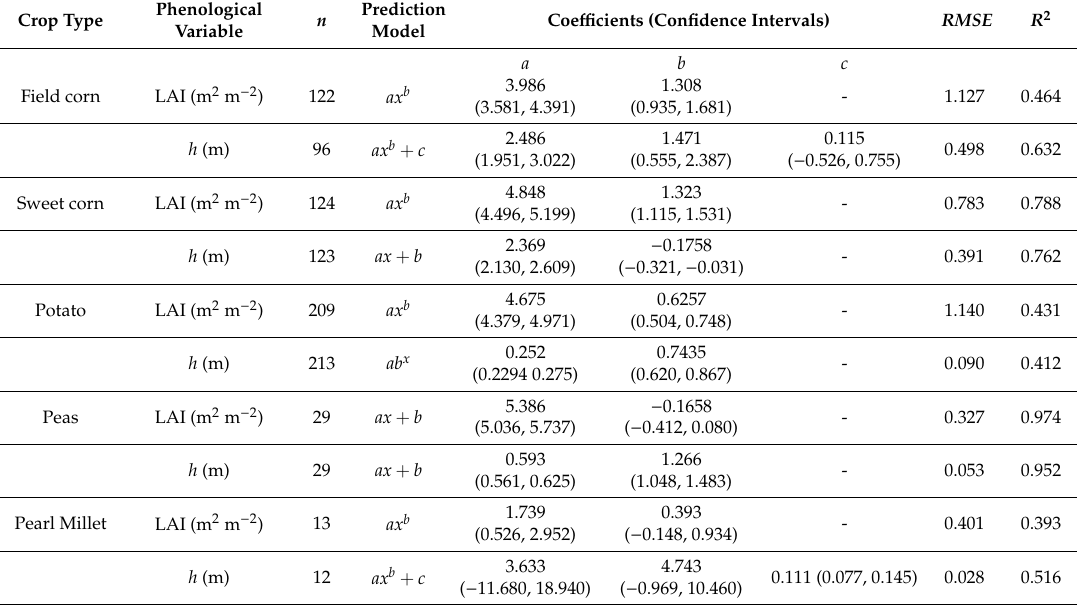
Table A1. LAI-EVI and height-EVI